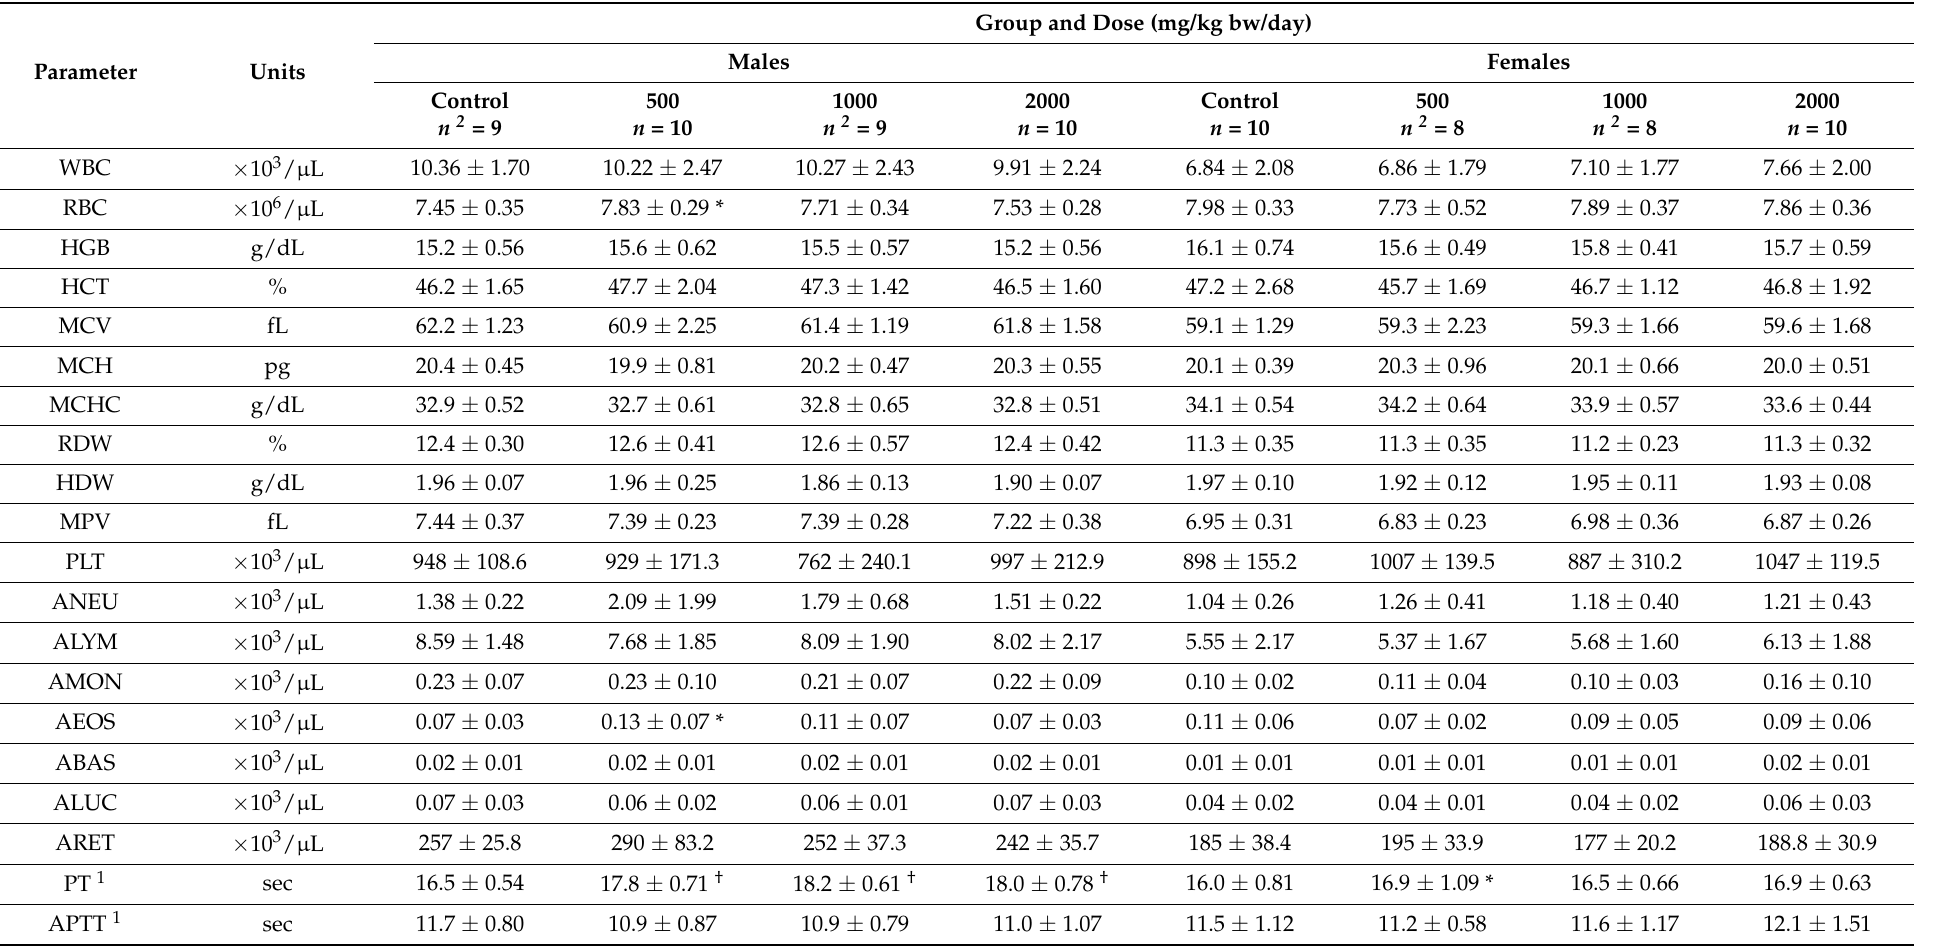
Table 3. Effect of 14 day oral administration of B. subtilis MB40 on hematological parameters in male and female